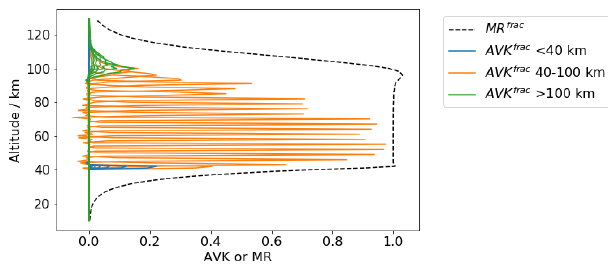
Figure 3. Every third row of the fractional AVK (solid lines) and measurement response (dashed black line) from the retrieval of vol- ume emission rate of the image 570 indicated in Fig.